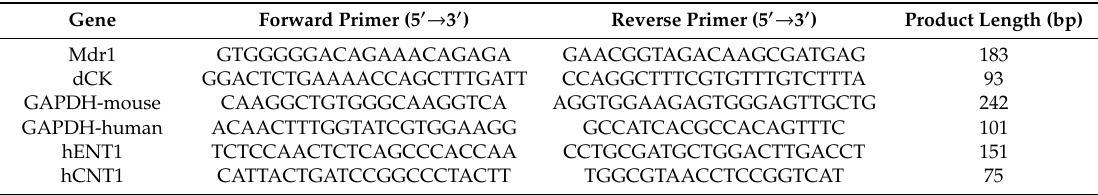
Table 3. Primer sets for quantitative